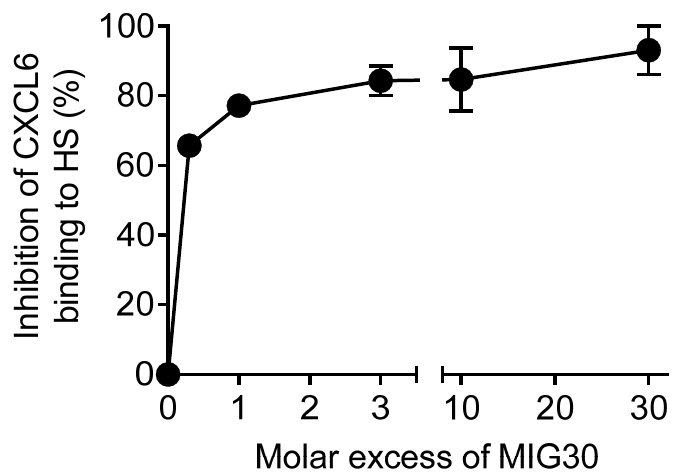
Figure 1. MIG30 inhibits the binding of CXCL6 to heparan sulfate GAGs. Competition between CXCL6 and MIG30 peptide for binding to immobilized heparan sulfate was evaluated on 96-well plates. CXCL6 (300, 100, 30, 10 and 3 nM) was added to heparan sulfate plates in the presence/absence of MIG30 (CXCL9(74-103); 100 nM). Bound CXCL6 was detected with biotinylated anti-mouse CXCL6 antibody. The data shown are the mean ± SEM of the percent of inhibition compared to CXCL6 binding alone.